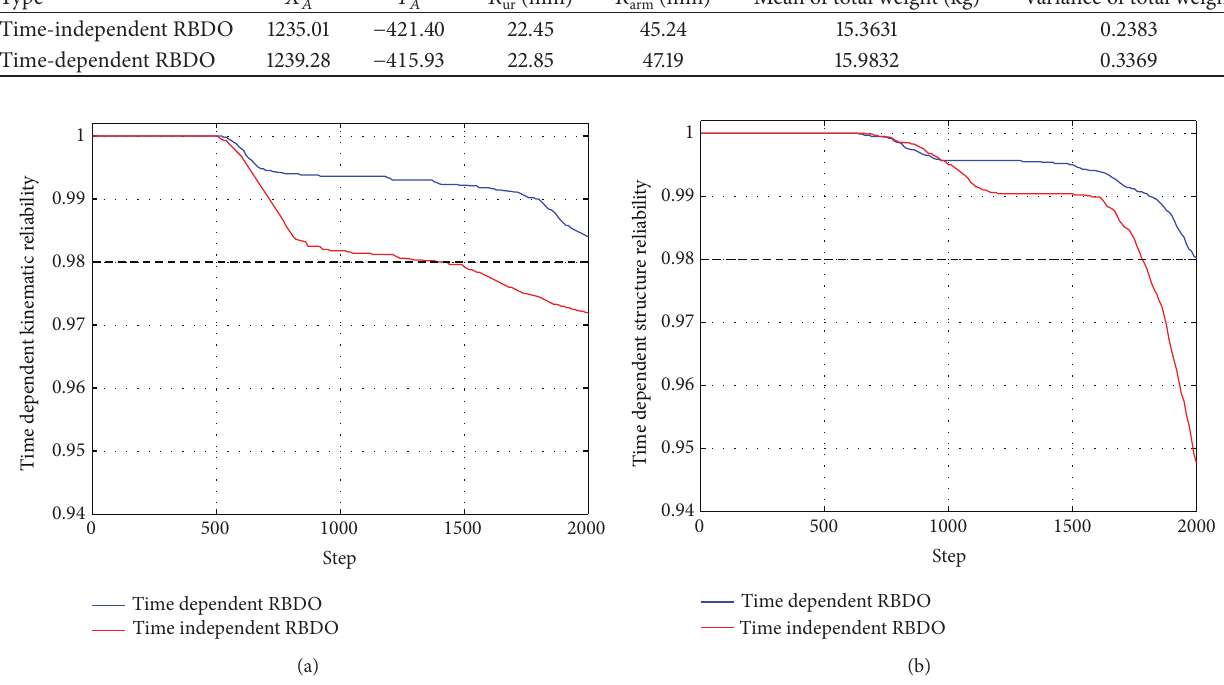
Figure11:Comparisonoftime-dependent reliability curves bytime-dependent RBDOandtime-independent RBDO.(a)Curvesofkinematic reliability; (b) curves of structure